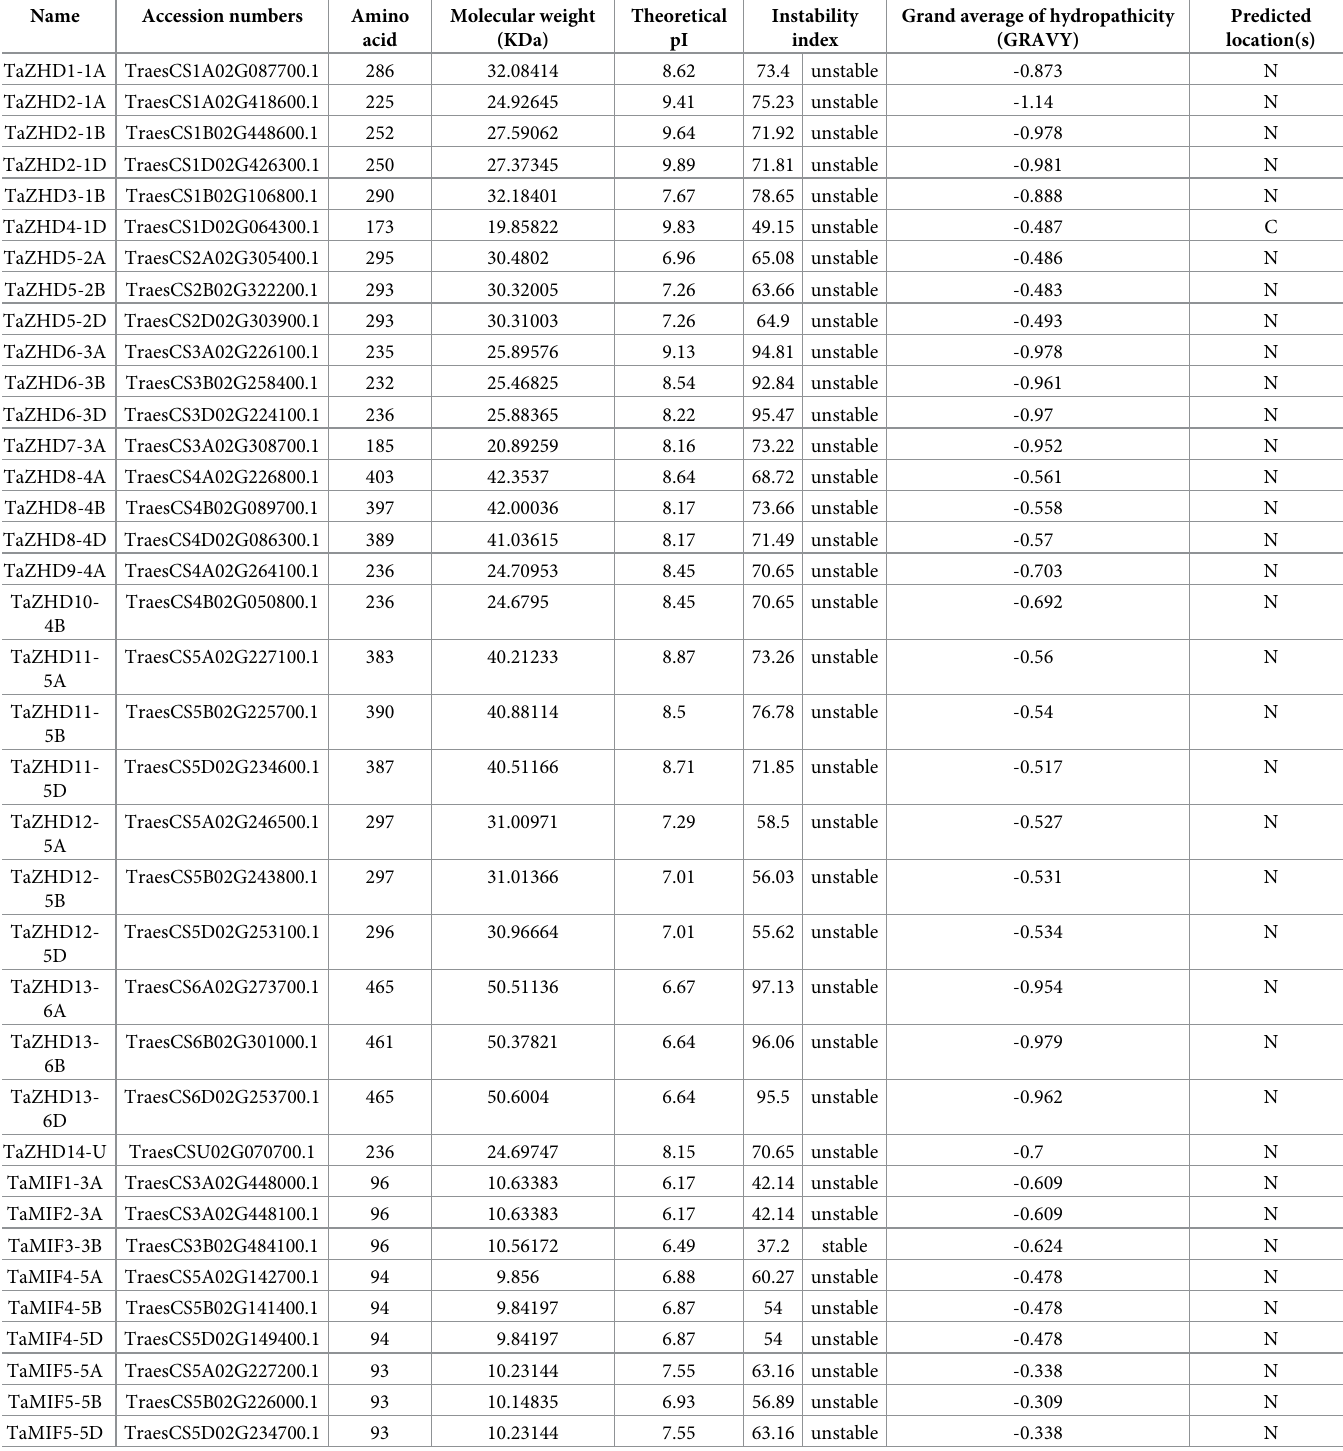
Table 1. Characterization of ZF-HD proteins in